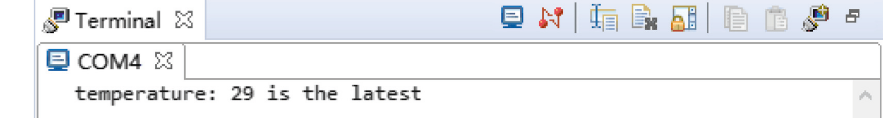
Figure 17: Temperature data format.